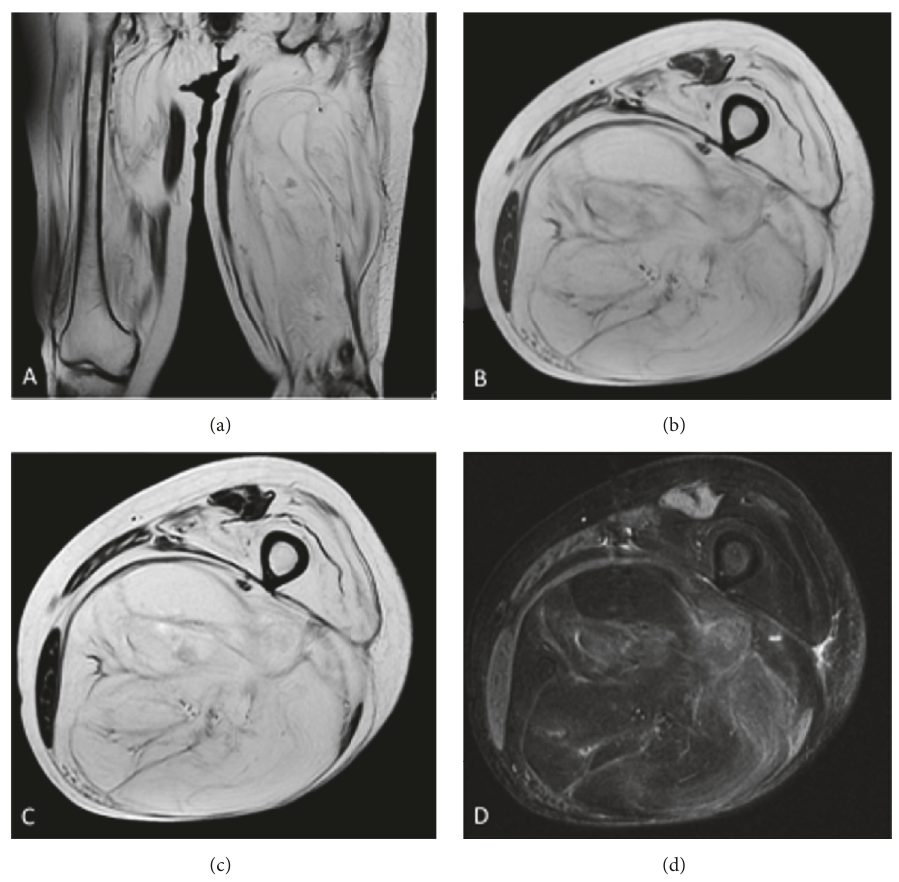
Figure 1: Magnetic resonance imaging revealed a tumor mass measuring 13 × 15 × 24 cm located in the left posterior thigh. Almost all the muscles, except the rectus femoris, sartorius, and gracilis muscles, show lipomatous changes. T1- and T2-weighted images (WIs) T2-WI, and short-TI inversion recovery (STIR) images show high intensity. Coronal T2-WI (a), T1-WI (axial view) (b), T2-WI (axial view) (c), and STIR images (axial view)